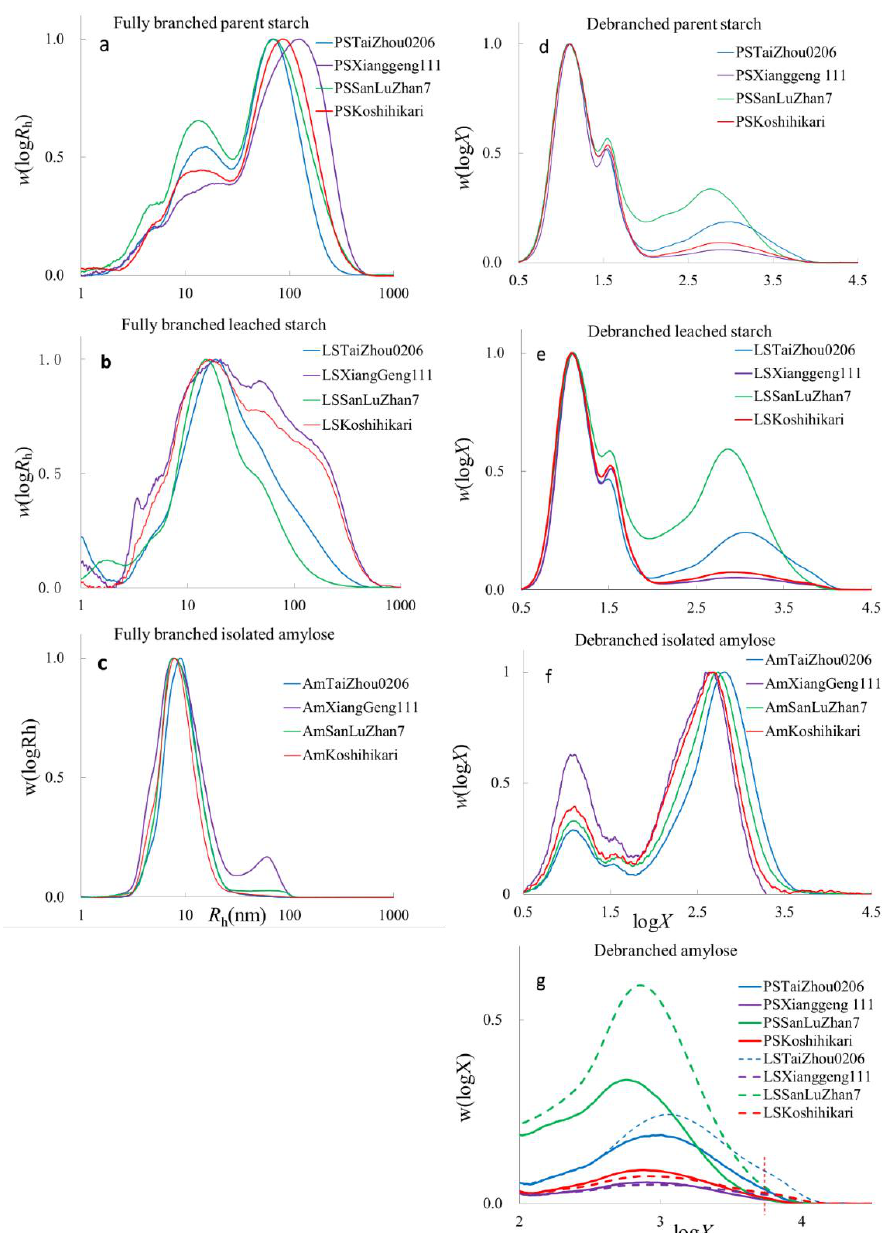
Figure 1. SEC weight distributions of branched and debranched starch molecules. ( a , d ): parent starches; ( b , e ): leached starches; ( c , f ): isolated amyloses. ( a – c ): plots of w (log R h ) for fully branched samples plotted against R h . ( d – f ): plots of w (log X ) for debranched samples plotted against DP ( X ); ( g ): enlarged representation of the amylose portion for parent starch and leached starch. The vertical broken line in ( g ) indicates the extra peak in leached starches, which is difficult to see in the parent starches.